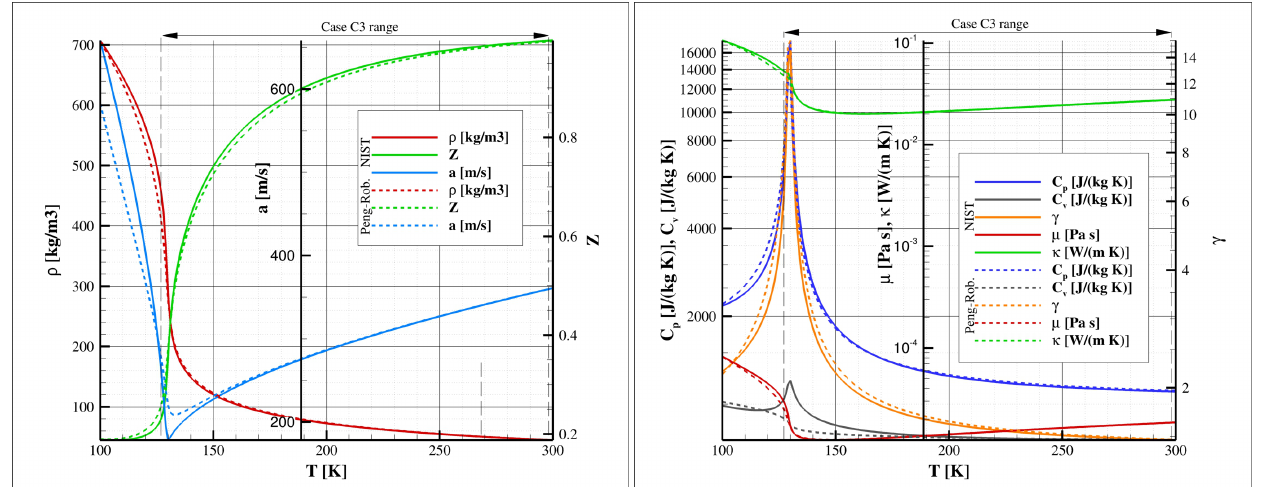
Figure 3. Comparison of some real gas properties estimated through the translated volume Peng– Robinson EoS and NIST reference data for N 2 at 39.7 bar as in the non-reacting Mayer’s test case: density ρ , sound speed a, compressibility factor Z, specific heat ratio γ = C p / C v , viscosity µ , thermal conductivity κ